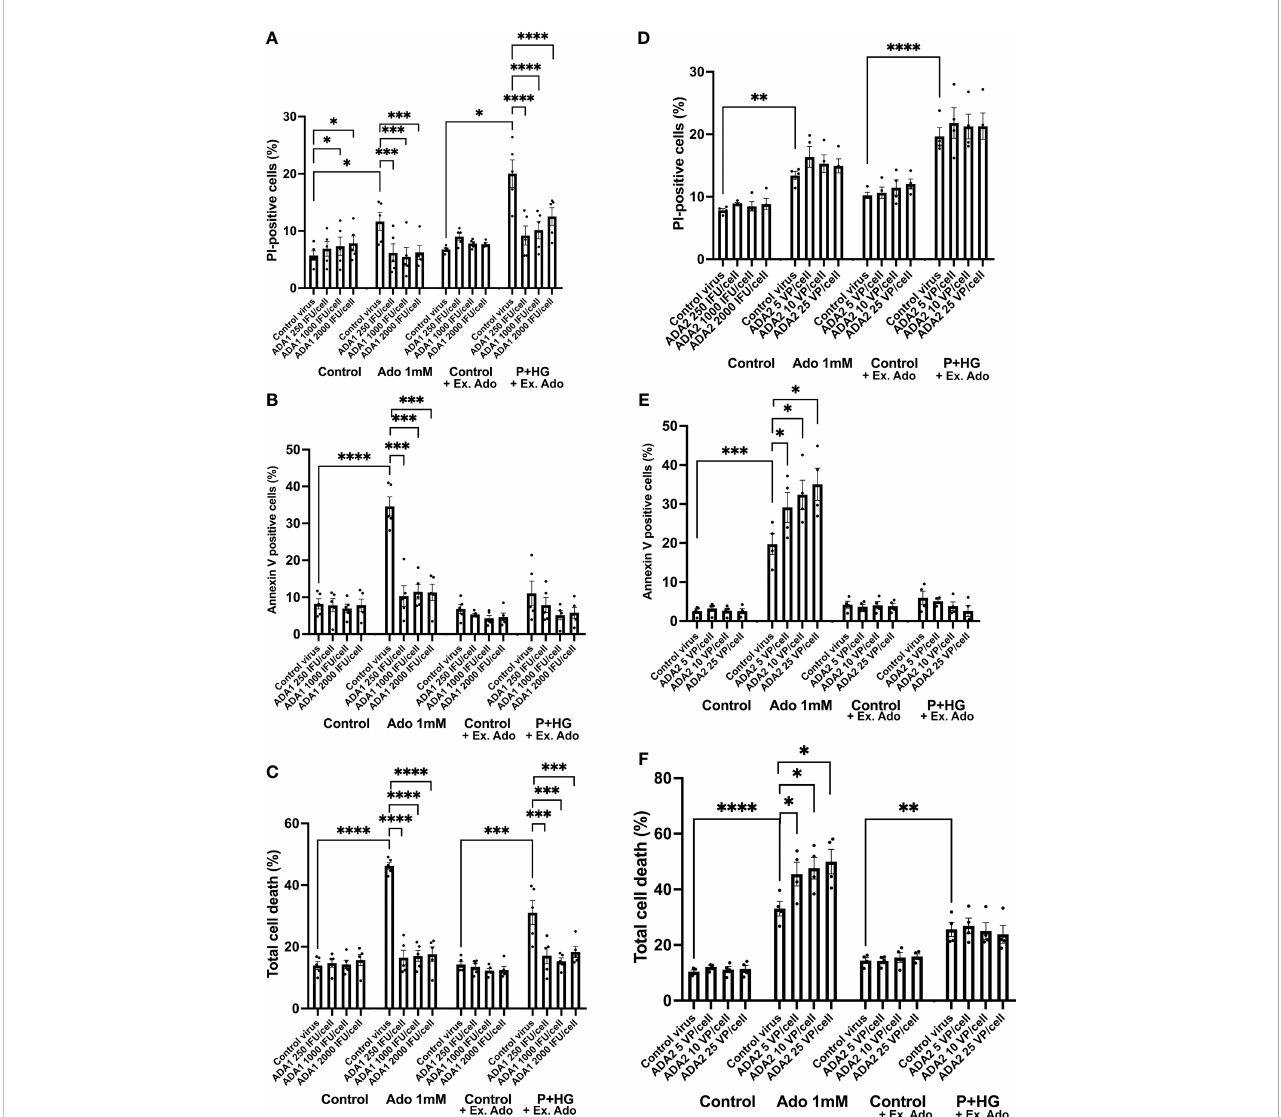
FIGURE 5 Overexpression of ADA1, but not ADA2, protects against adenosine and palmitate + high glucose-induced EndoC-betaH1 cell death. EndoC-betaH1 cells were transduced with ADA1 (A – C) and ADA2 (D – F) adenoviral vectors at the concentrations given in the Figure. The next day, cells were incubated at control conditions or with adenosine (Ado 1 mM) or palmitate + high glucose (P+HG, 1.5 mM palmitate + 20 mM glucose) for an additional 18h. Controls to the P+HG groups and the P+HG groups were supplemented with 50 m M adenosine. Cell apoptosis (Panels and necrosis rates were then analyzed by PI (A, D) and Annexin V staining (B – E) and fl ow cytometry. Total cell death (C, F) was calculated by adding together PI and Annexin V cell